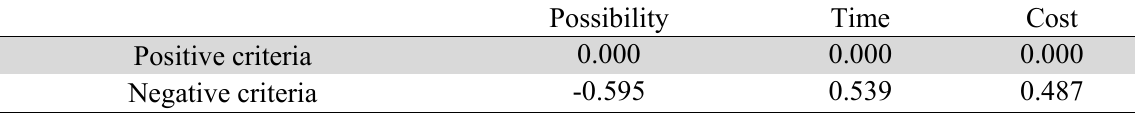
Positive and negative criteria